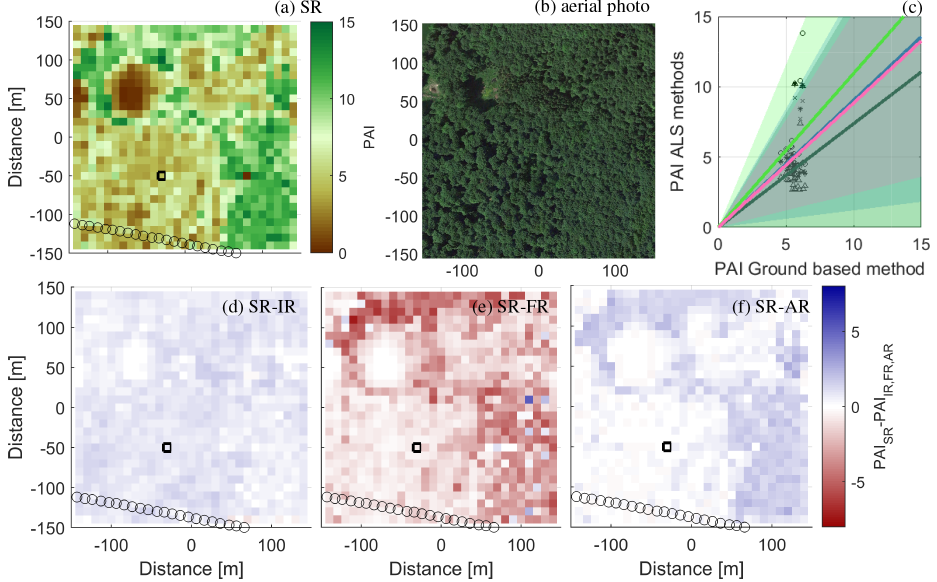
Figure 3. PAI estimates from the summer scan at the dense beech forest Falster site: (a) SR method; (b) an aerial photo (©Google Earth 2020) over the site; (c) a scatterplot of the ground-based estimates and the ALS methods. The lines show linear regression forced through zero with the shading indicating the 95% confidence level (1.96 times the standard error). SR is represented using the blue line and stars, IR is represented using the dark green line and triangles, FR is represented using the bright green line and circles, and AR is represented using the pink line and crosses. The circles in the maps display the positions of the ground-based measurements. Panels (d) , (e) , and (f) show the difference between SR and the IR, FR, and AR reference methods, respectively. The black square marks the edges for the data used in Sect.